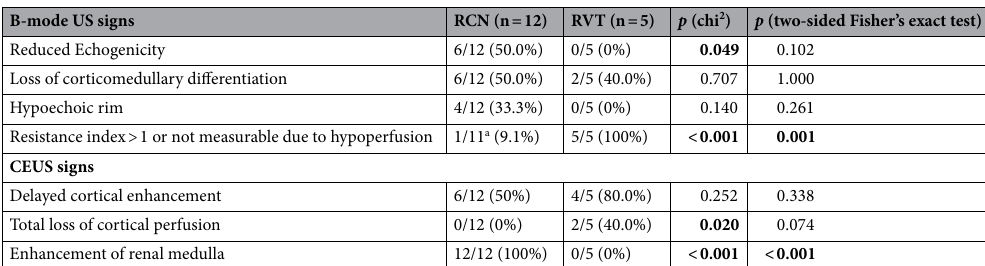
Table 3. Comparison of B-mode US and CEUS findings in RCN and RVT. A p -value < 0.05 indicating statistical significance is marked bold. Continuous variables are given as median (IQR), categorical variables as absolute/total numbers (n/N) and percentages in brackets. RCN denotes renal cortical necrosis, RVT renal vein thrombosis, US denotes ultrasound, CEUS denotes contrast-enhanced ultrasound. a Missing image data in one